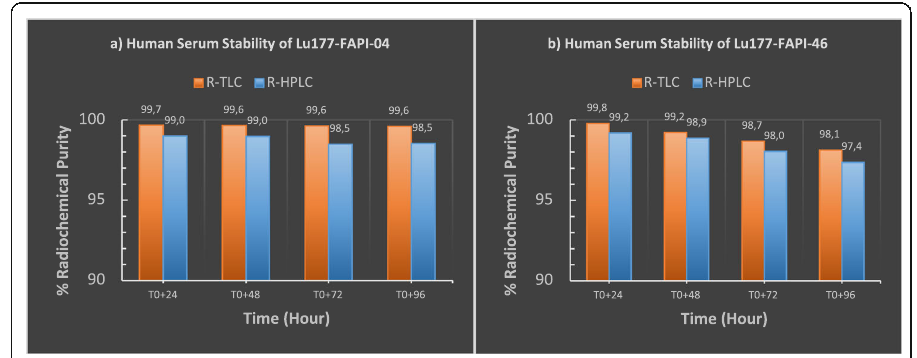
Fig. 8 Human serum stability study of [ 177 Lu]Lu-FAPI-04 & [ 177 Lu]Lu-FAPI-46 at 37 °C ambient temperature. a Radiochemical purity results of [ 177 Lu]Lu-FAPI-04 analyzed by R-TLC & R-HPLC: T0 + 24 h, T0 + 48 h, T0 + 72 h, T0 + 96 h. b Radiochemical purity results of [ 177 Lu]Lu-FAPI-46 analyzed by R-TLC & R-HPLC: T0 + 24 h, T0 + 48 h, T0 + 72 h, T0 + 96 h . (T0 = End of the